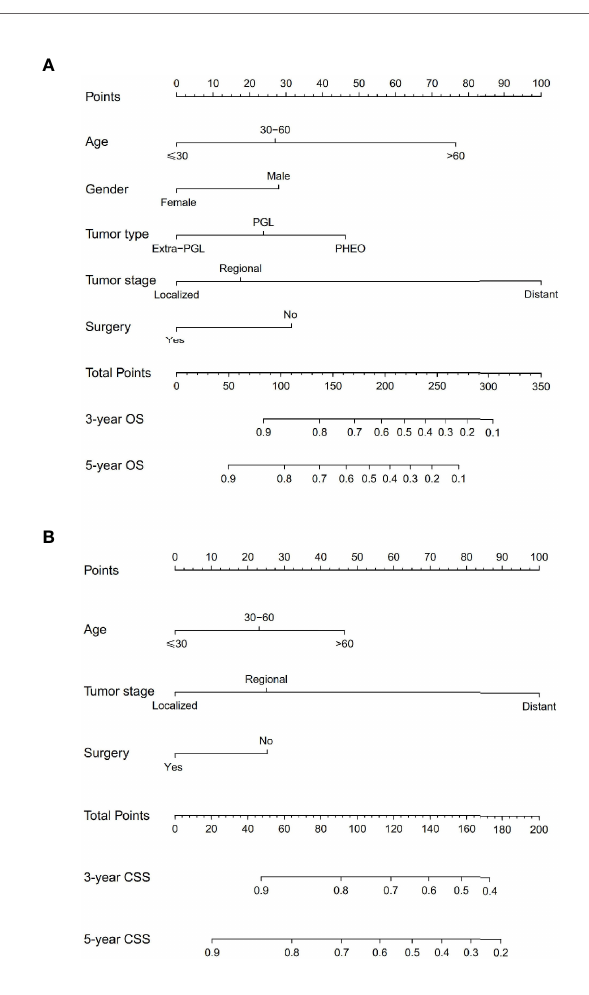
FIGURE 5 | Nomograms predicting 3- and 5-year OS (A) and CSS (B) of patients with malignant PPGL.